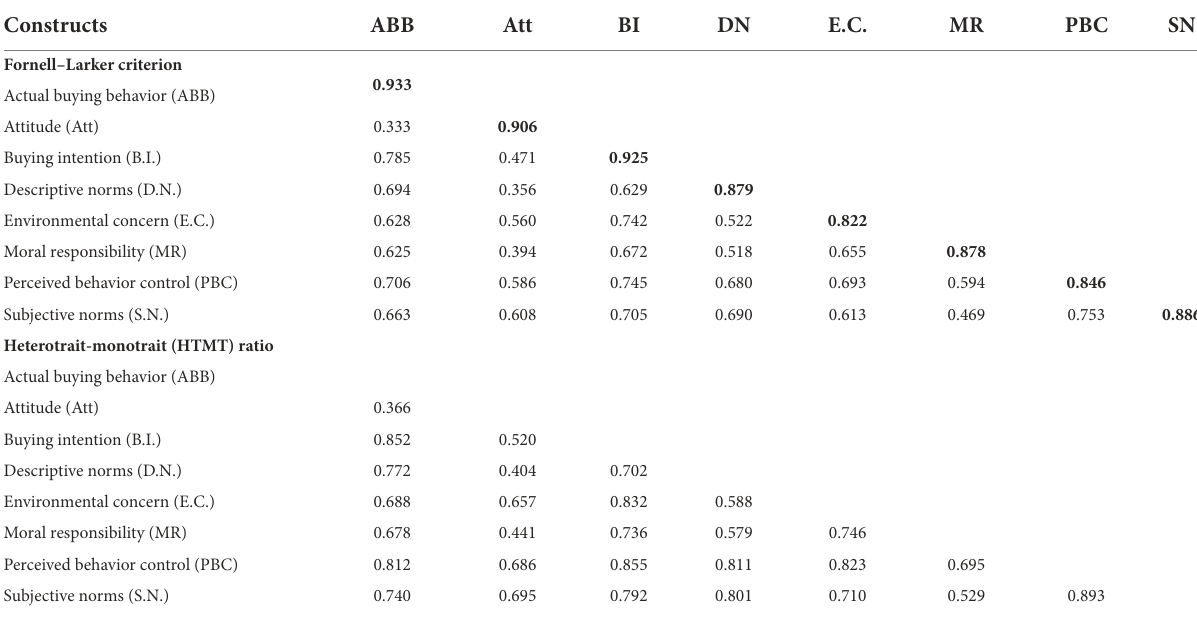
TABLE 3 Discriminant